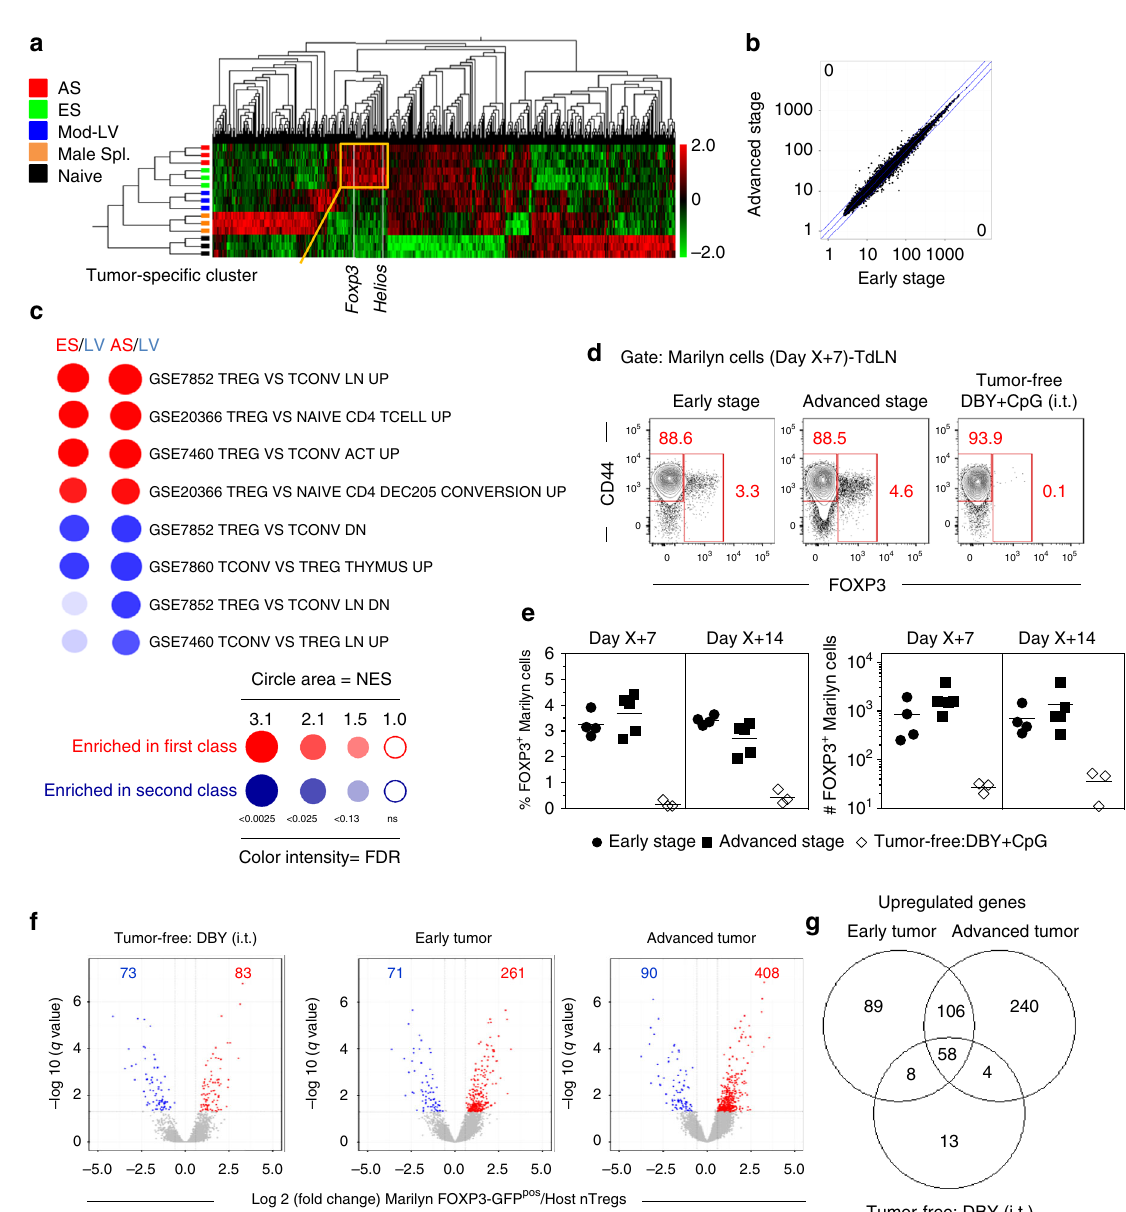
Fig. 2 Activated tumor Ag-speci fi c CD4 + T cells display a Treg phenotype. a – c Gene expression pro fi le of FACS-puri fi ed total Marilyn cells harvested 7 days after transfer from the TdLN of mice bearing ES or AS tumors. Controls are naive Marilyn cells (Naive) and activated Marilyn cells from tumor-free B6 mice primed with male splenocytes (Male Spl.) injected into the footpad (f.p.) or injected with the Mod-LV i.t. (Mod-LV). a Heat map and hierarchical clustering of the most differentially expressed genes ( q = 0.05). The yellow square indicates the tumor-speci fi c cluster. b Gene expression level comparison between Marilyn cells from mice bearing ES or AS tumors (no difference at q = 0.05). c Bubblemap of gene set enrichment analysis of ES vs. LV, or AS vs. LV conditions. NES, Normalized enrichment score, FDR, False discovery rate. d FOXP3 expression by Marilyn cells. e Frequency and number of FOXP3 + Marilyn cells. Representative of one out of three independent experiments. f Volcano plots representing the q value against fold-change gene expression for FACS-puri fi ed Marilyn pTregs (FOXP3-GFP pos ) vs. polyclonal host nTregs from unmanipulated mice (CD4 + CD25 hi ). Marilyn pTregs were puri fi ed from the Med-LNs of tumor-free mice receiving 200 ng of DBY i.t. or mice bearing early or advanced tumors, 7 days after the adoptive transfer of the naive cells. Upregulated or downregulated genes (Fold change>1.5, q < 0.05) are highlighted in red and blue, respectively. g Venn diagram of